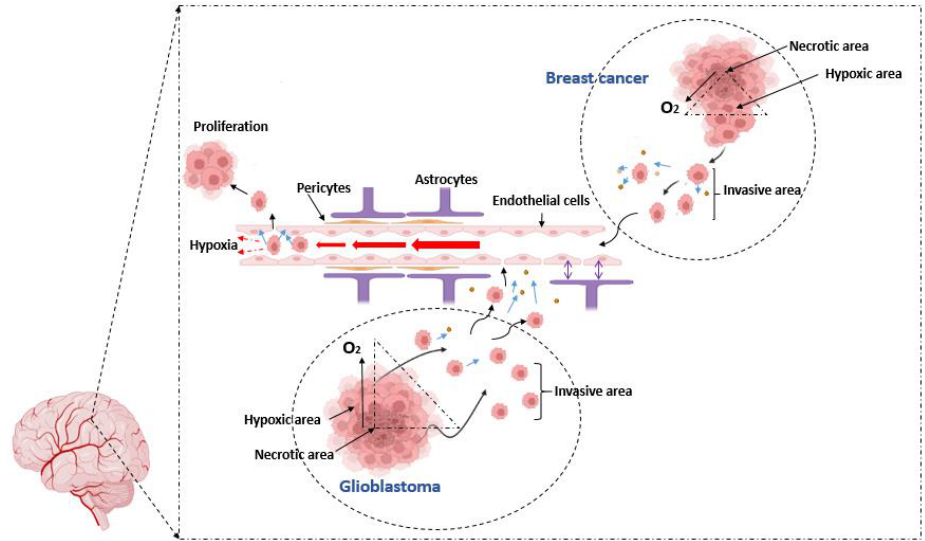
Figure 4. Schematic illustration compares our postulates on the metastatic mechanism of brain cancer cells (GBM) and metastatic brain cancer cells (breast cancer) to compromise the brain capillary: Both brain cancer and breast cancer are solid tumours, characterised by tumour zones of low levels of O 2 , facilitating the transformation of primary tumour cells into differentiated metastatic cancer cells. The core of the fast-growing tumour forms a necrotic zone (dying or dead cells) which is surrounded by a hypoxic zone where cancer cells are metabolically modified by the low O 2 level. Hypoxic cells are transformed into invasive cells, which tend to detach from the tumour and migrate to the blood vessels, forming invasive areas. Cancer cells in the invasive area secrete factors (proteases: blue arrows), enhancing their passage into the blood vessel. Cancer cells migrate with the bloodstream and are arrested to the luminal surface of brain capillaries, creating complex interactions with endothelial cells, initially via soluble paracrine factors released from cancer cells before the physical adhesion, to facilitate the movement of cancer cells through the endothelium. Simultaneously, attachment of cancer cells to the lumen drastically reduces blood flow (blood flow rate (F) is proportional to the radius (r) of the blood vessel: F α r 4 ), resulting in the formation of relative hypoxia both proximally and distally to the site of cancer cell attachment. The effect of hypoxia on BECs cause increased permeability, compromising the integrity of the capillary endothelium which facilitate the metastasis of cancer cells into the brain [34 – 36].